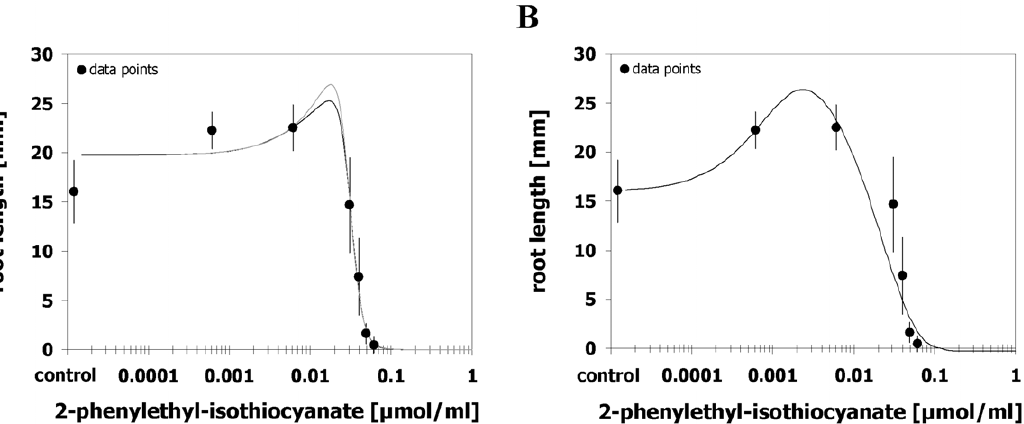
Figure 1. Both logistic hormetic models unsuitable. Dose-response relationship for the effect of 2-phenylethyl-isothiocyanate on root growth of Amaranthus hybridus and its description by the hormetic dose-response models after Brain and Cousens [9] (grey curve) or Cedergreen et al. [2] (black curve) (A). (B) Response modelling by the An-Johnson-Lovett Model II [24] (black curve). Only the An-Johnson-Lovett Model II [24] showed a significant hormetic effect. Error bars represent standard deviation.